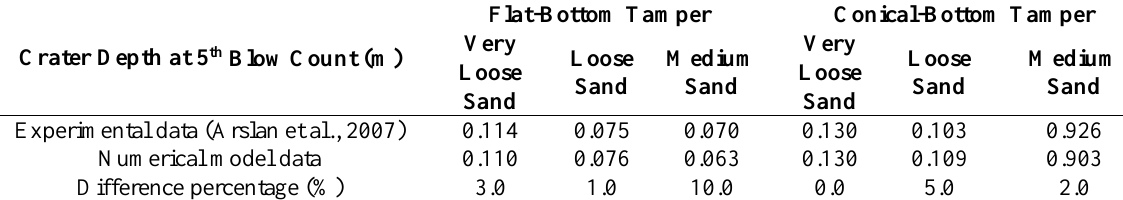
Table 2. Comparison of results of numerical modeling and experimental data